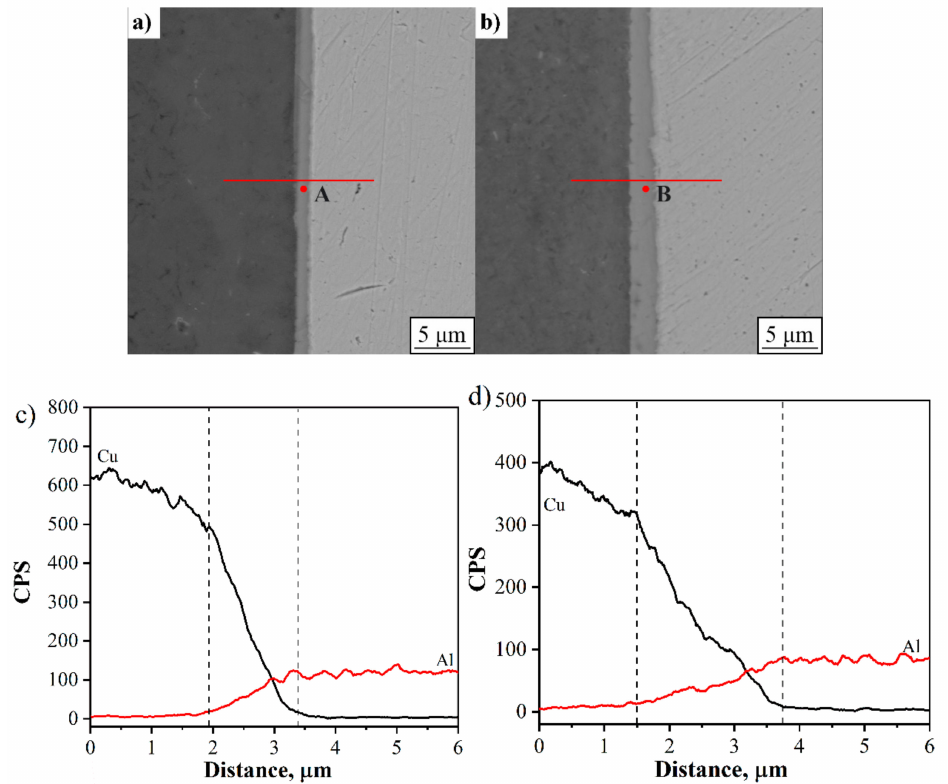
Figure 6. ( a , b ) Cu / Al interface in the RUSW and high-power ultrasonic welding (HPUSW) joints, respectively; ( c , d ) EDS results for the lines intersecting the points indicated in ( a , b ).